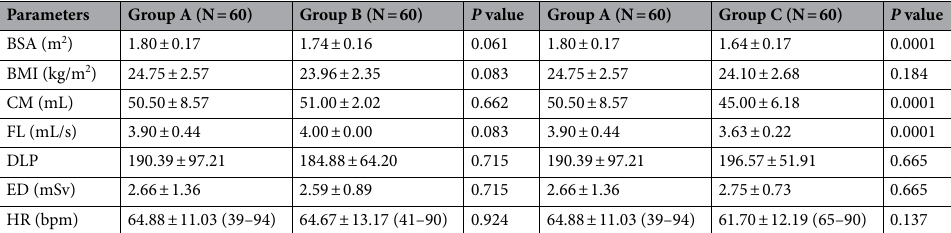
Table 3. Patient characteristics and radiation dose comparison. BMI, body mass index; BSA, body surface area; CM, contrast medium; DLP, dose length product; ED, effective radiation dose; FL, flow rate; HR, heart